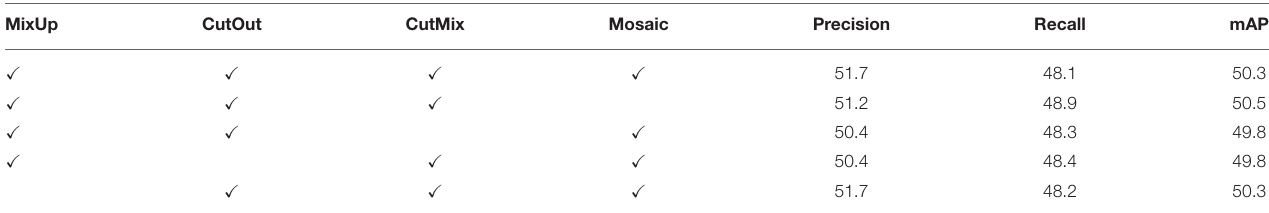
TABLE 3 | The ablation experiment results from different pre-processing methods (in %). MixUp CutOut CutMix Mosaic Precision Recall mAP